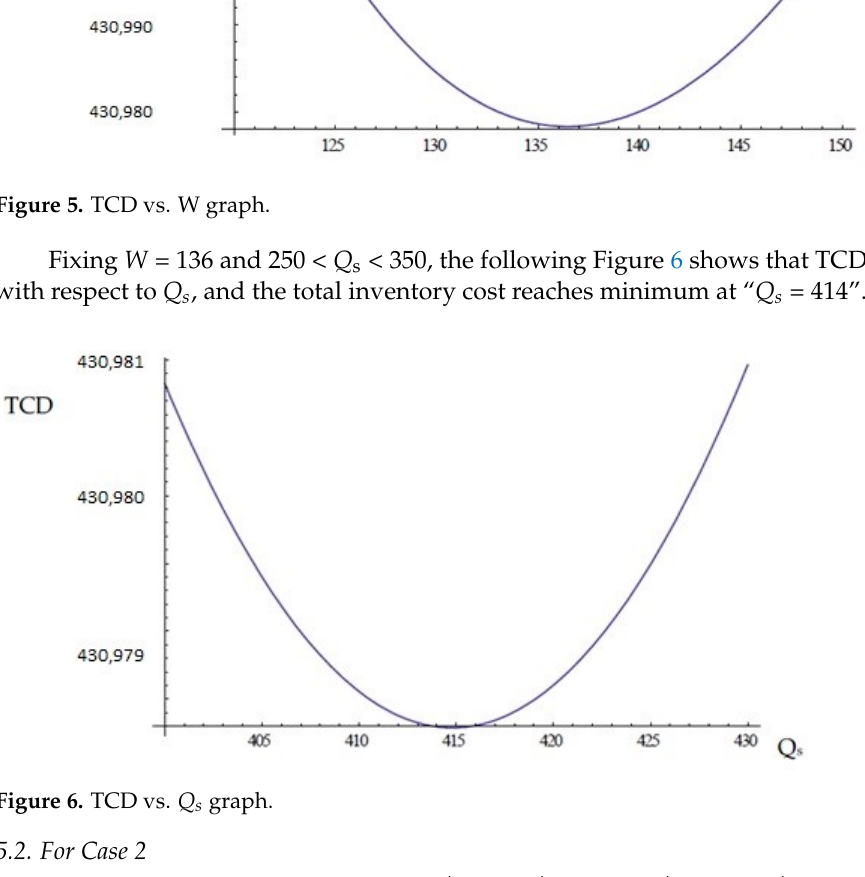
Figure 6. TCD vs. Q s graph.